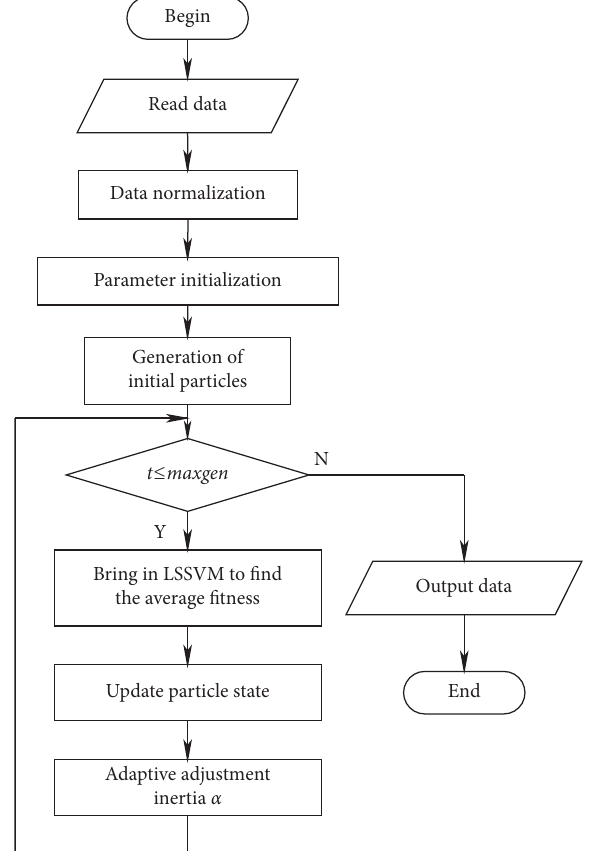
Figure 6: Flowchart of the PSO-LSSVM algorithm for adaptive